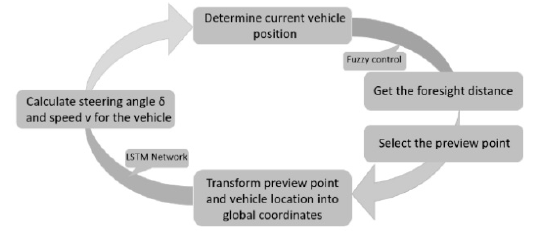
Figure 4. The overall structure of the proposed trajectory tracking algorithm.